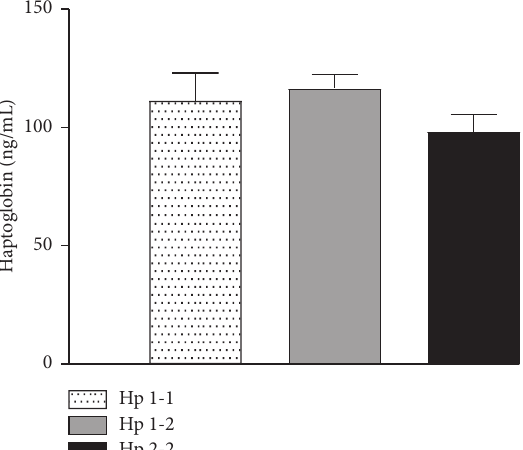
Figure 2: Levels of haptoglobin in the Hp1-1, Hp1-2, and Hp2-2 phenotypes. Data are expressed as mean ± SD. Phenotype 1-1: speckled line and bar; phenotype 1-2: grey line and bar; phenotype 2-2: black line and